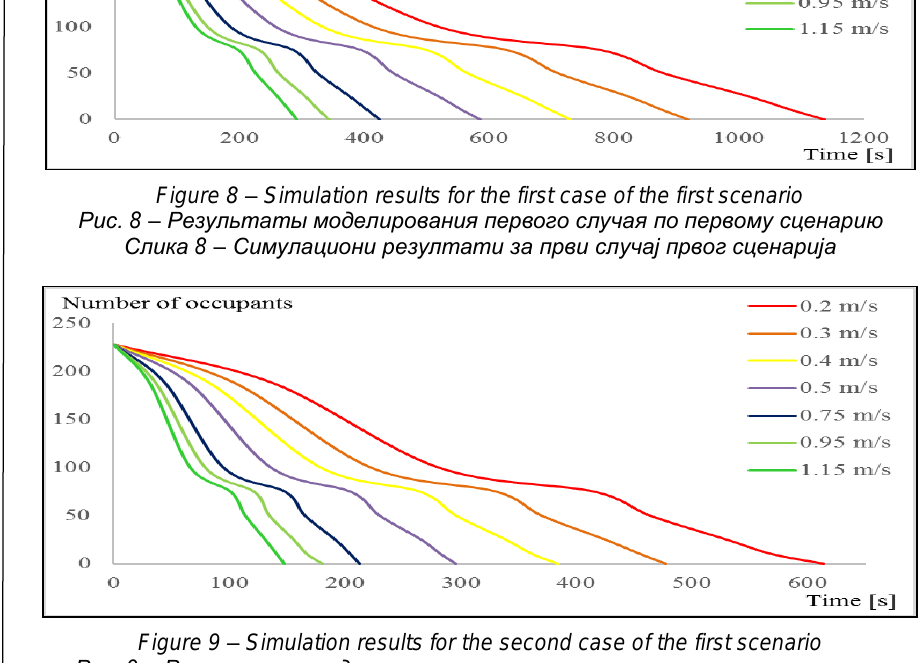
Figure 9 – Simulation results for the second case of the first scenario Рис. 9 – Результаты моделирования второго случая по первому сценарию Слика 9 – Симулациони резултати за други случај првог сценарија